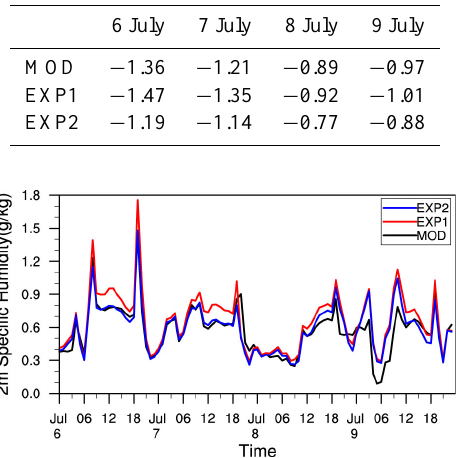
Table 2. Differences of averaged air temperature at 2m above ground between the oasis and the desert (oasis minus desert) dur- ing the time period from 06:00 to 18:00BT for the MOD, EXP1 and EXP2 simulations ( ◦ C).